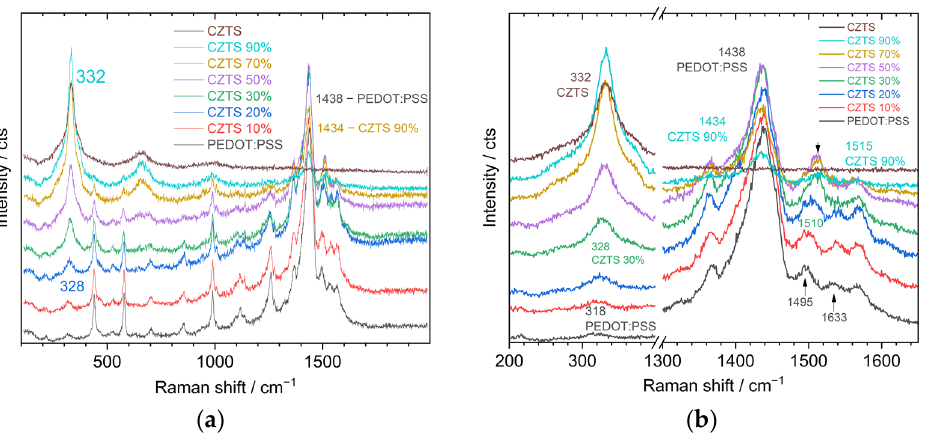
Figure 2. Raman spectra for ( a ) composite films with different contents of CZTS NCs in PEDOT:PSS: in the full spectral range of NCs and polymer vibrations, and ( b ) in the range of the main CZTS phonon and polymer bands.